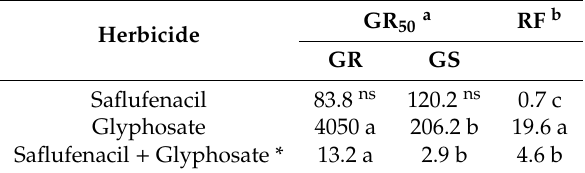
Table 1. Parameter estimates of herbicide dose resulting in 50% reduction of total dry weight (GR 50 ) in glyphosate-resistant (GR) and -sensitive (GS) biotypes of Conyza bonariensis at 28 days after treatment